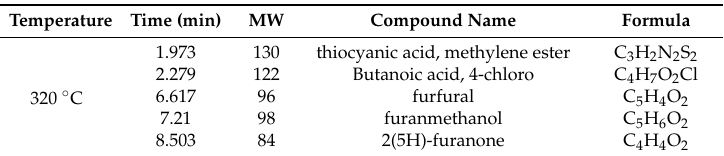
Table 3. TGA-GC-MS analysis results for sawdust.